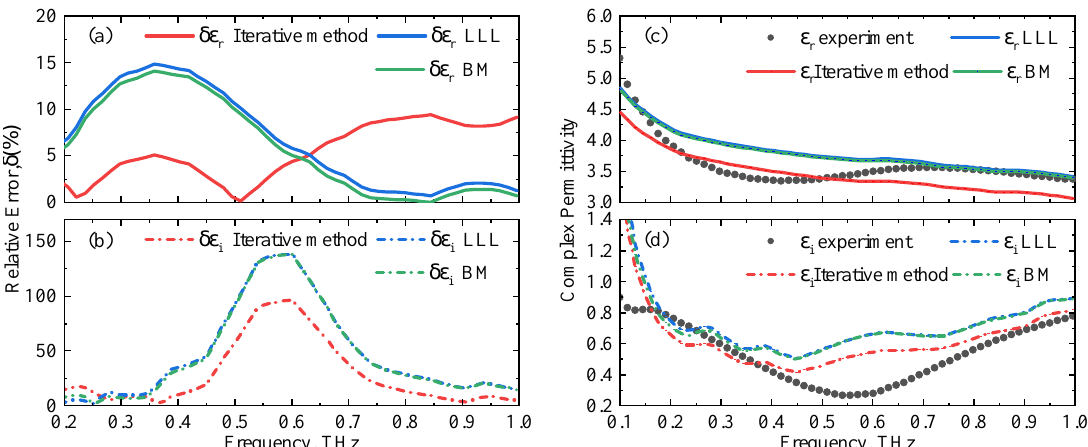
Figure 4. ( a , b ) Comparison of the experimental and simulated effective complex permittivity of the five-component biopolymer with 9% bentonite (LLL—Landau–Lifshitz–Looyenga model, BM—BG model). ( c , d ) The relative errors of the EMT models. Upper—real part of the complex permittivity. Lower—imaginary part of the complex permittivity.